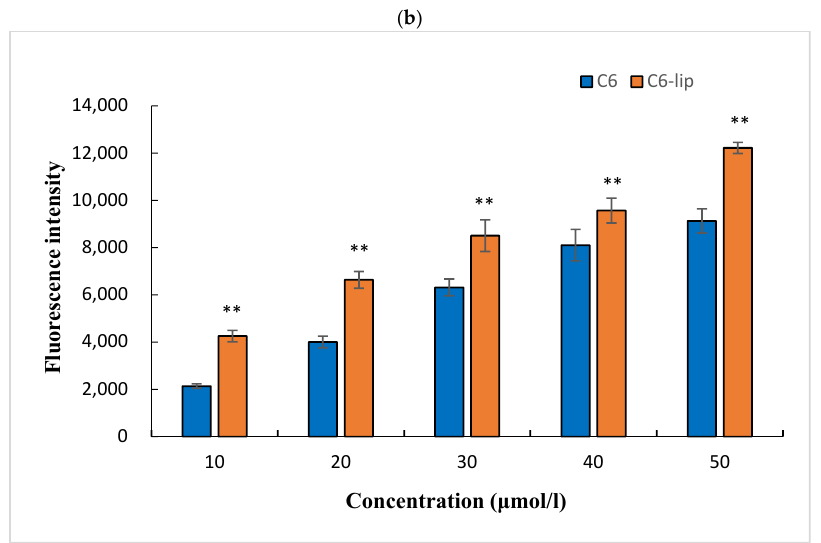
Figure 6. Cellular uptake of C6 and C6-liposomes into MCF-7 cells: ( a ) Microscopy images of MCF-7 cells treated with different concentrations C6-liposomes for 4 h; ( b ) Fluorescent intensity of C6 and C6-liposomes in MCF-7 cells after incubation for 4h. ** p < 0.01.